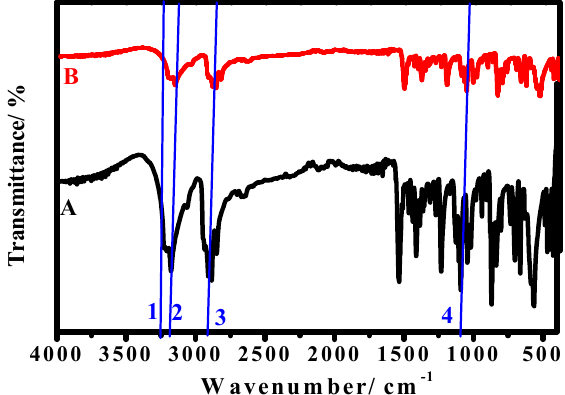
Figure 8. FTIR analysis in a range of 400–4000 cm −1 of (A) crude Ad-Th and (B) surface film of C-steel sample after immersion in 1.0 M HCl containing 200 ppm of Ad-Th for 48 h at 50 °C.